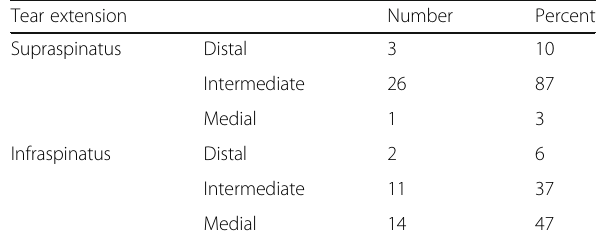
Table 4 Medio-lateral extension of